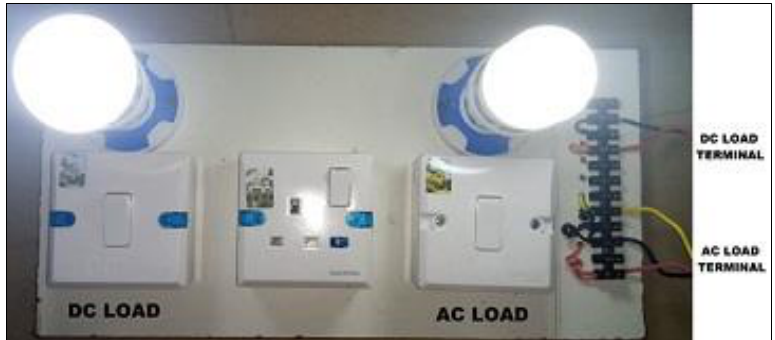
Figure 6: Hybrid Load on Wooden Board when